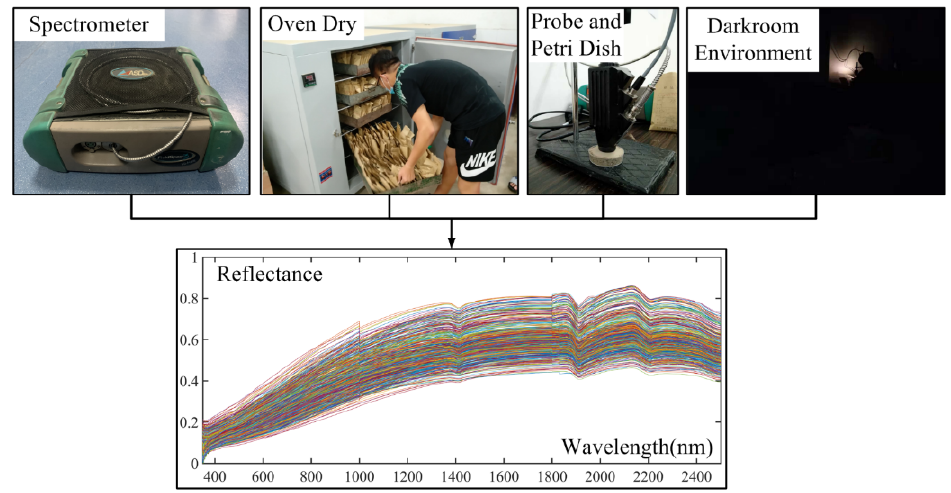
Figure 2. The photos show the instruments and experiment environment. The graph shows the reflectance spectra of all soil samples.